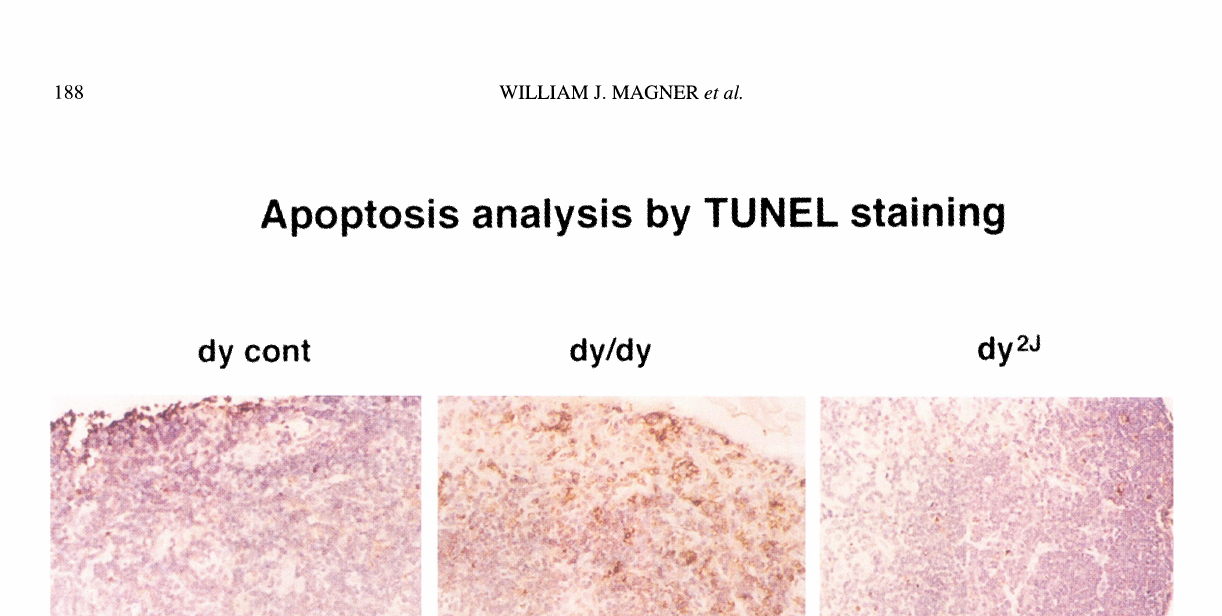
FIGURE 4 Histochemical analysis for apoptotic cells. To analyze apoptotic cell death in dystrophic mice, the TUNEL staining technique was applied to sections of thymi from dystrophic and control mice. The subcapsular region of the dy/dy thymus clearly contains significantly more apoptotic cells than the section from its control littermate. This supports our hypothesis of increased apoptotic death in an early thy- mocyte population. TUNEL staining of the dy 2J thymi and their wildtype controls did not show any visible difference in apoptosis in the dy 2J (see Color Plate XIII at the back of this